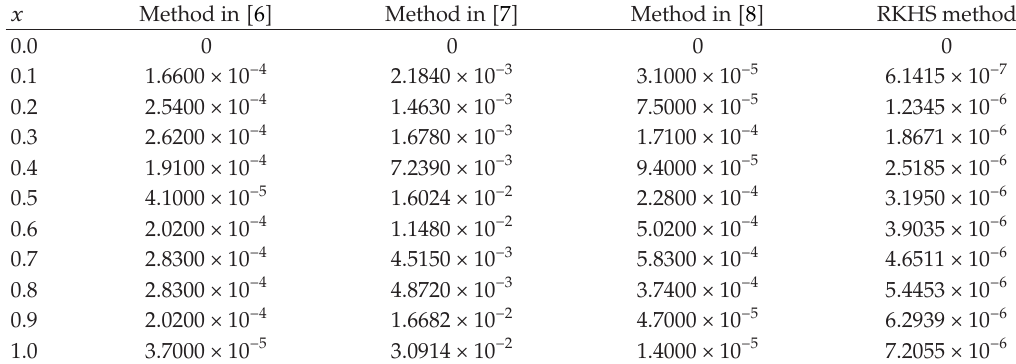
Table 3: Numerical comparison of absolute error for Example 5.1.